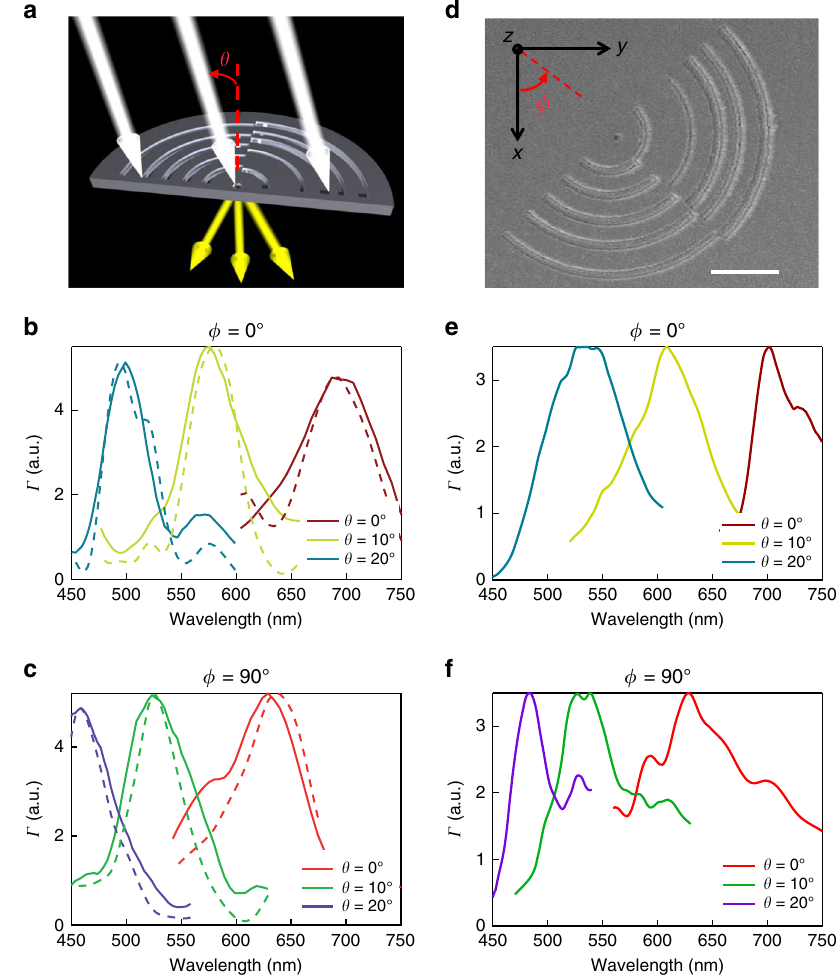
Fig. 4 Aperiodic bullseye directional light- fi lter. a Schematic illustration of the light transmission through an aperiodic bullseye structure consisting of two distinct radially integrated linear aperiodic slit-groove structures. b , c Relative transmission ( Γ ) spectra calculated using the interference model of Eq. (3) (solid lines) and FDTD simulations (dashed lines) for θ = 0°, 10°, and 20° at both ϕ = 0° ( b ) and 90° ( c ). The calculated and simulated spectra agree with each other and demonstrate the incident angle ( θ ) and sample orientation ( ϕ ) dependent multi-spectral response of the device. d Top-down scanning-electron-microscope image of the bullseye device fabricated following the same procedure as the linear structure. The central circular aperture diameter in the bullseye structure is 150 nm and the scale bar represents 4 μ m. The sample orientation ( ϕ ) relative to the axis of the bullseye is de fi ned in the inset. e , f Experimentally measured Γ spectra corresponding to simulated spectra in b , c ,